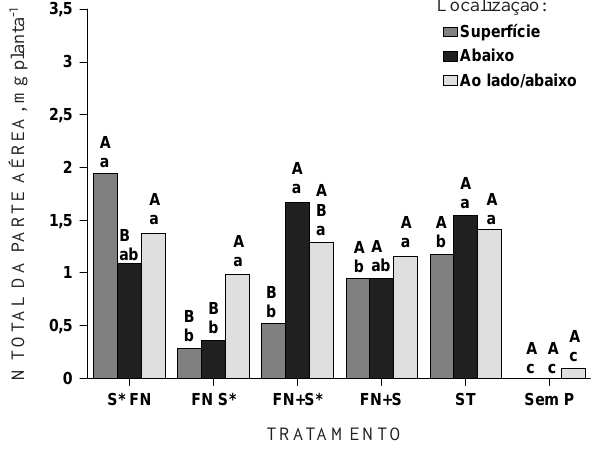
Figura 5. N total acumulado na parte aérea do jacatupé, nos tratamentos FN revestindo o enxofre inoculado com Acidithiobacillus (FN S*), FN revestido com S inoculado com Acidithiobacillus (S* FN), mistura FN com S inoculado com Acidithiobacillus (FN + S*), mistura FN com S sem Acidithiobacillus (FN + S), superfosfato triplo (ST) e sem adição de fósforo (sem P) de acordo com a localização do adubo. Letras minúsculas comparam as de P em cada modo de localização do adubo; as maiúsculas, cada tratamento com P nos diferentes modos de localização do adubo. C.V. % = 7,31.